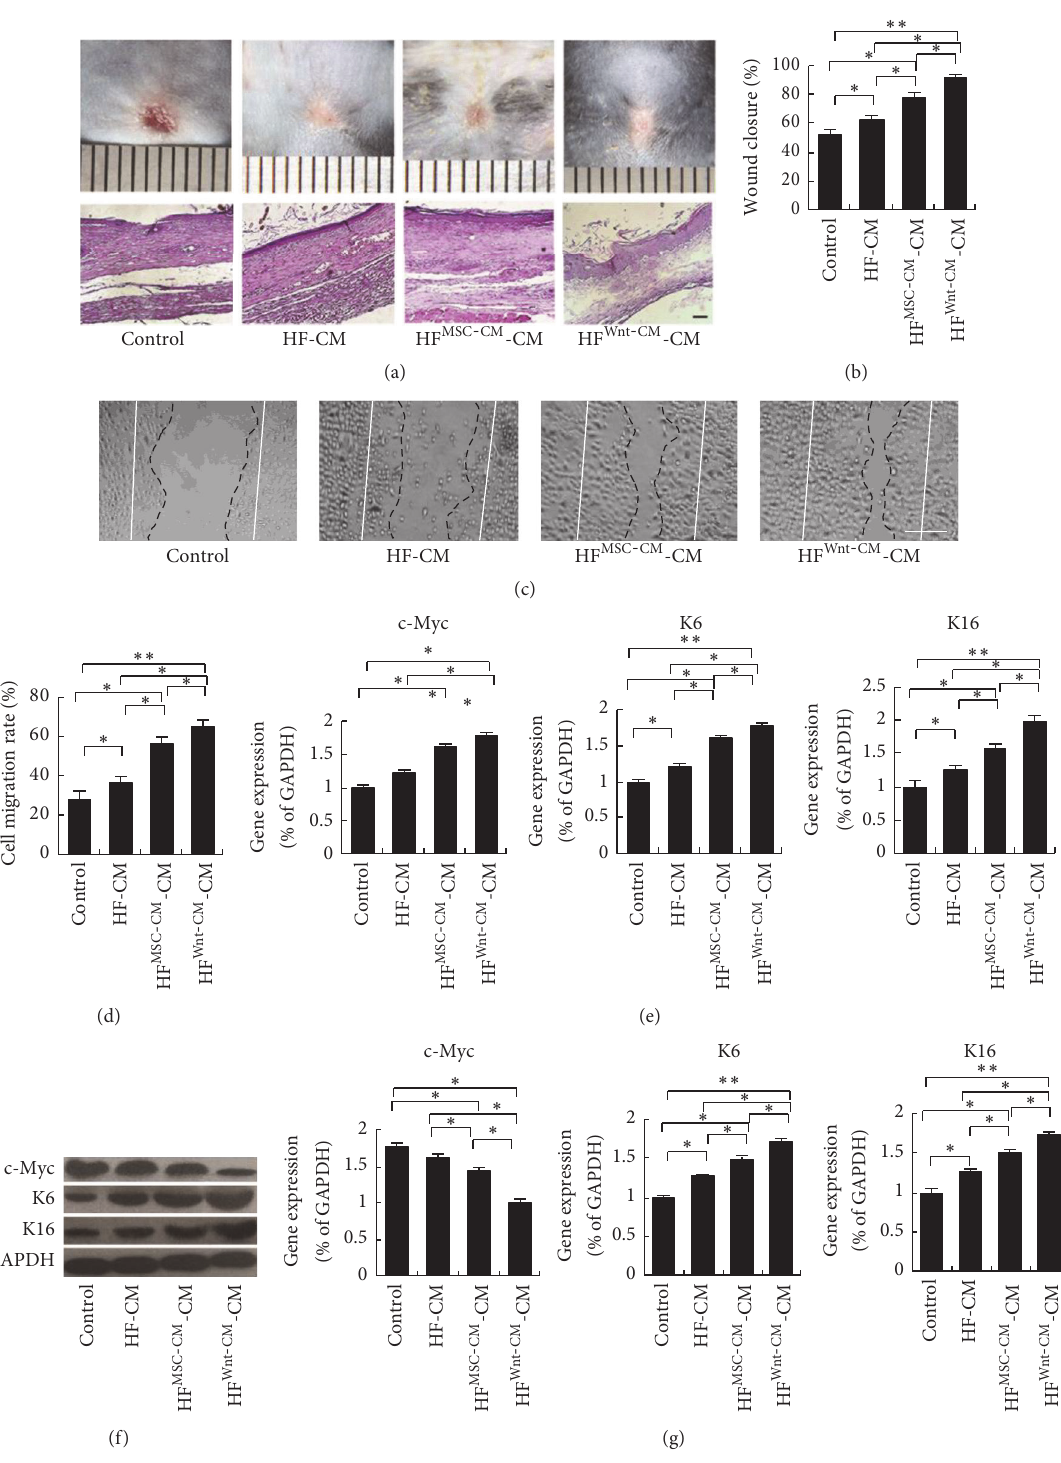
Figure 7: HF Wnt-CM -CM enhances migration and expression of the cytoskeletal components K6 and K16 in human keratinocytes. (a) Typical images of dorsal skin showing effectiveness of wound closure in the mice and H&E-stained histological slices of treatments groups HF Wnt-CM - CM, HF MSC-CM -CM, and HF-CM. (b) Evaluation of wound closure by morphometrical analysis of wound areas (ImageJ, NIH). (c and d) HF Wnt-CM -CM enhanced migration of human keratinocytes in a wound scratch assay after 24 h as compared to HF MSC-CM -CM, HF-CM, and DMEM and corresponding semiquantitative analysis data. (e) Expression levels of c-Myc, K6, and K16 mRNA after treatment with HF Wnt-CM - CM, HF MSC-CM -CM, or HF-CM were analyzed by real-time PCR and normalized to that of GAPDH. (f, g) Western blots analysis of c-Myc, K6, K16, and corresponding semiquantitative analysis. The data represent mean ± SEM, 𝑛 = 3 ; ∗ 𝑃 < 0.05 and ∗∗ 𝑃 < 0.01 . Solid lines indicate the initial wound area; dotted lines demarcate the migrating front of the cells. The scale bar is 100 𝜇